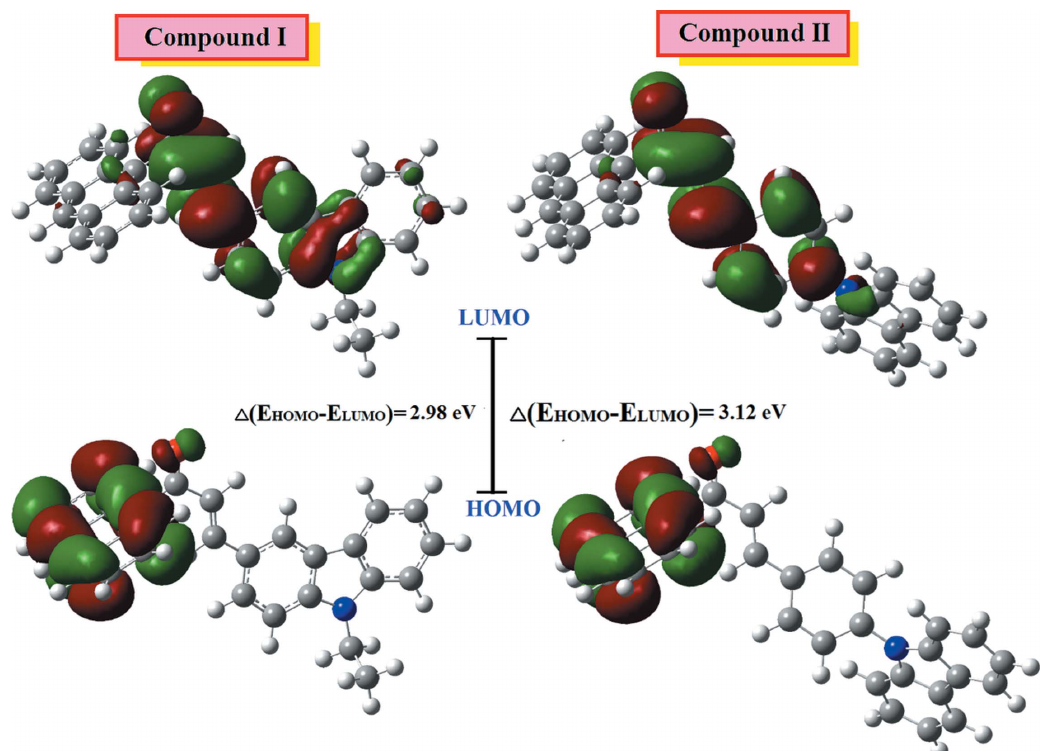
Figure 4 The electron distribution of the HOMO and LUMO energy levels of compounds I and II .